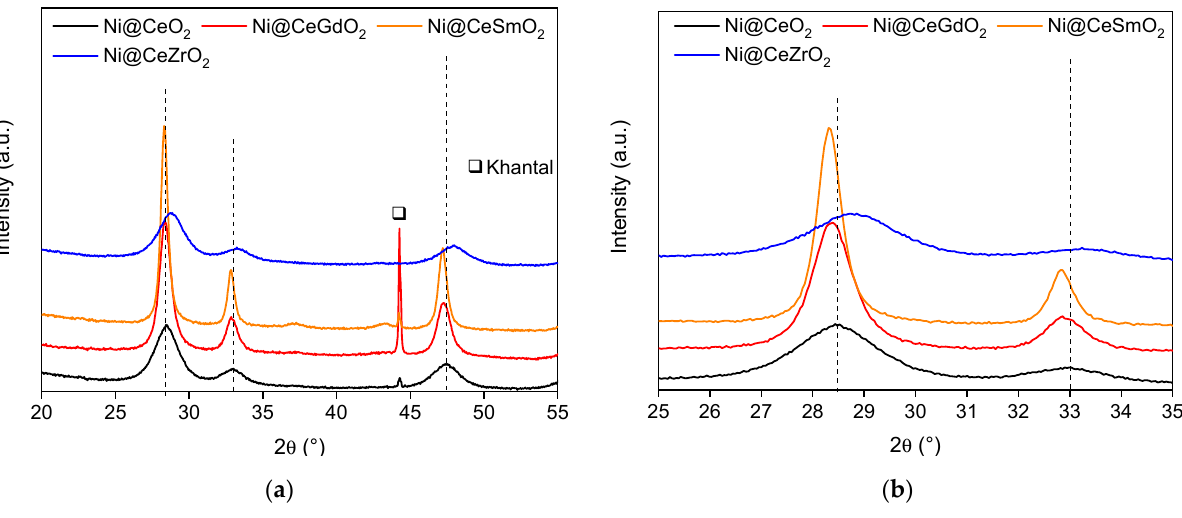
solutions [32,39–41]. The lines characteristic of NiO were not detected in the diffracto- grams of the calcined samples, indicating the presence of highly dispersed particles, as observed in our previous work [6].